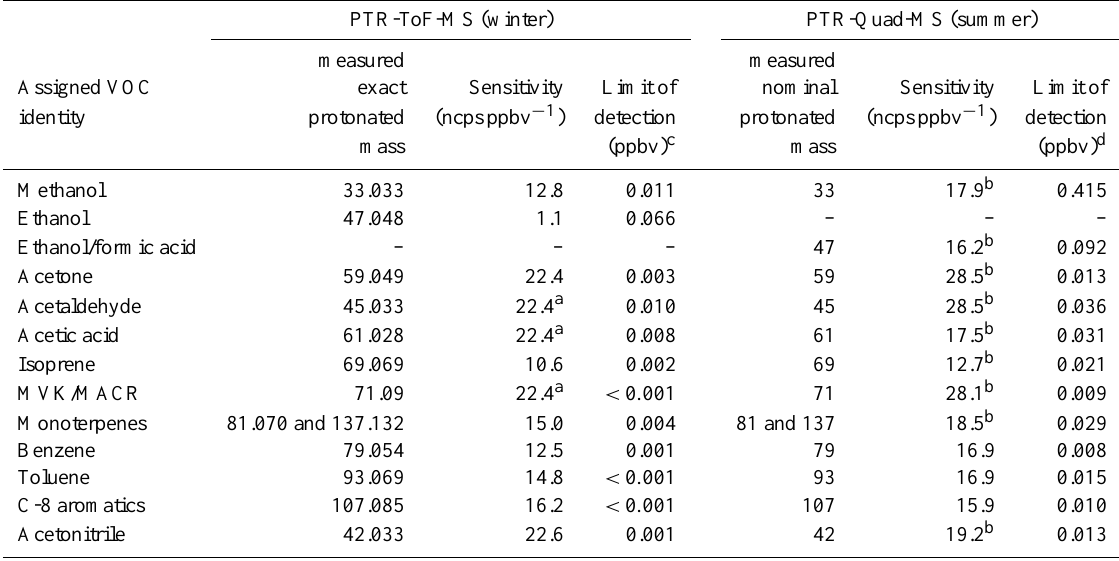
Fig. 1. Location of the Montseny (MSY) measurement site, in relation to the city of Barcelona. Table 1. Masses measured with the different PTR-MS systems and the corresponding VOC identity assigned to them. The mean sensitivity and the limit of detection for each VOC are also displayed. Sensitivities shown are transmission corrected and normalized to the primary ion signal, taking into account all major molecular fragments. Detection limits (DL) were inferred from a signal to noise ratio (S/N) of 2 according to DL=2 × SD blank /sensitivity, with SD blank being the standard deviation of background countrates, as reported elsewhere (Karl et al.,